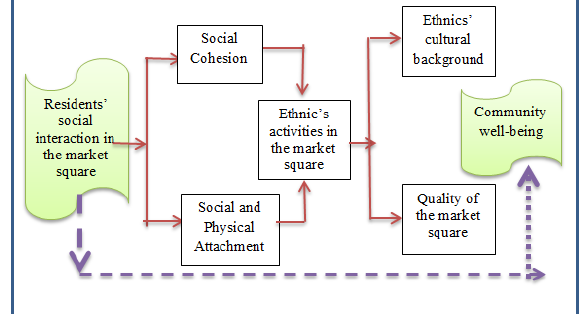
Figure 1. Conceptual frame